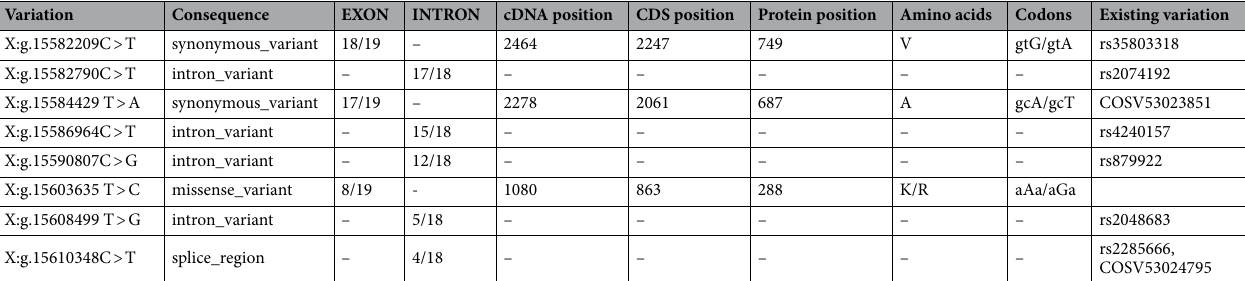
Table 1. ACE2 variants (SNPs) detected in COVID-19 lean and obese patients. Eight exonic and intronic ACE2 variants were detected in the 82 COVID-19 subjects using